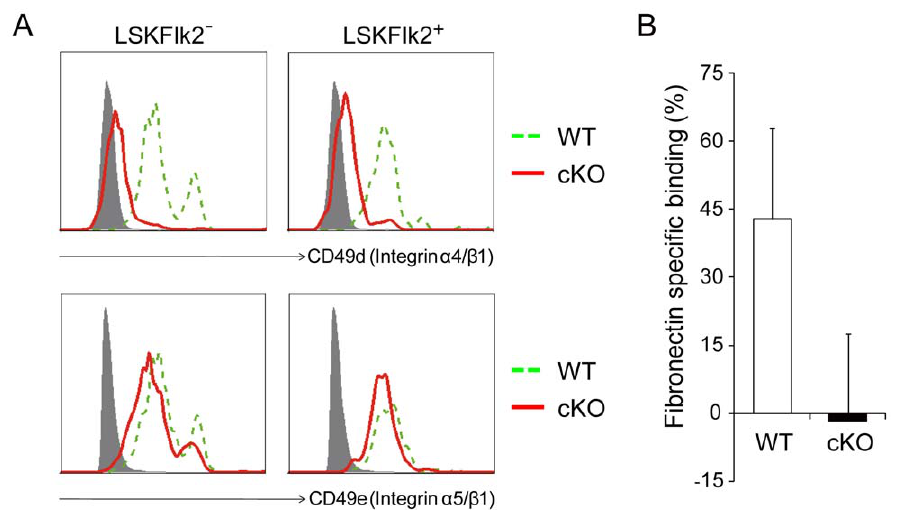
Figure 10. Inability of Grp94 KO HSCs to express surface integrin a 4 and bind to fibronectin. A) Representative flow cytometric analysis of CD49d and CD49e with BM LSKFlk2 2 and LSKFlk2 + cells from WT and cKO mice. Grey-filled histogram represents isotype control staining; dashed green line represents WT cells; solid red line indicates cKO cells. B) The percentage of WT and cKO LSK cells bound to fibronectin in vitro . The number of cells binding to BSA was subtracted from that binding to fibronectin, the results then were normalized against the number of WT cells bound to BSA. The experiments were performed twice in duplicate; each replicate contained pooled BM from 2 to 4 WT or cKO mice. The data are presented as mean 6 s.e..